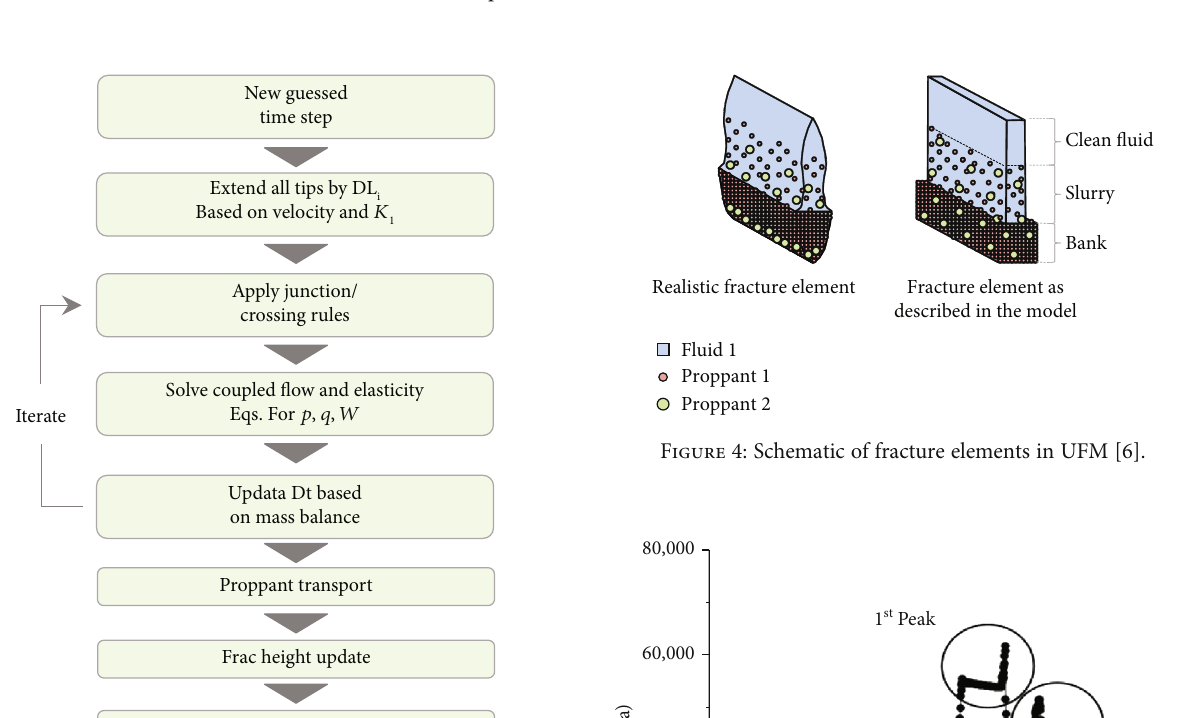
Figure 2: G -function plots of di ff erent leako ff mechanisms [11].